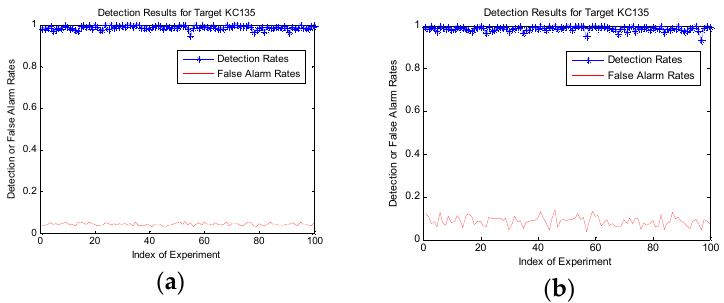
Figure 8. Detection and false alarm rates. In ( a ), the target and background are getting from the same